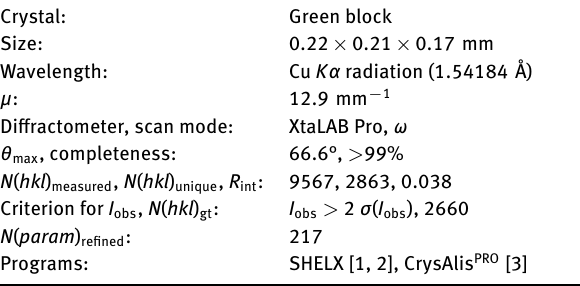
Table 1 contains crystallographic data and Table 2 contains the list of the atoms including atomic coordinates and dis- placement parameters.